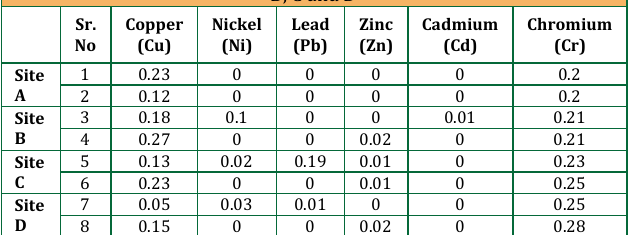
Table 4: Concentration of metals in Ground water (mg/L) from four Sr.no